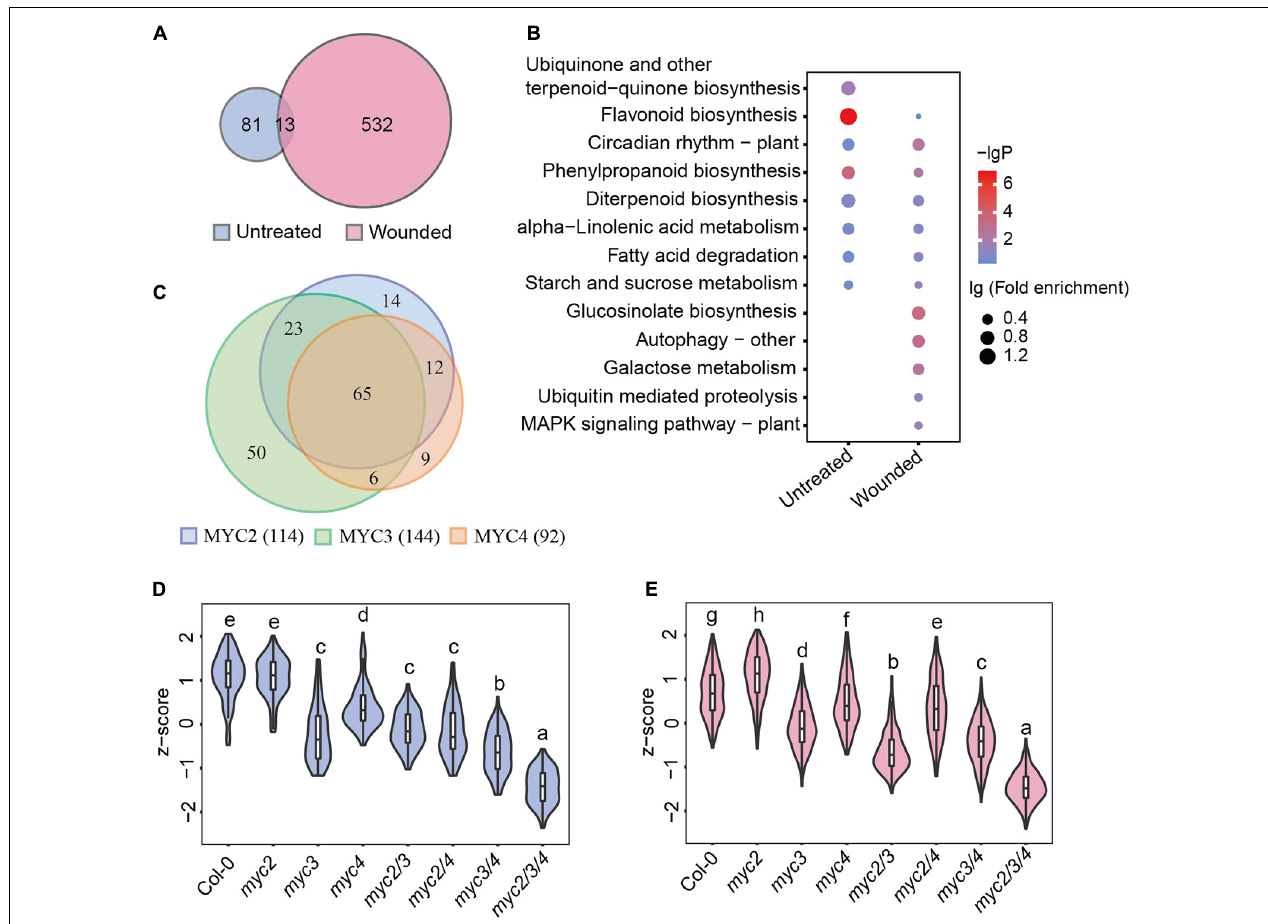
FIGURE 3 | MYC3 has the most significant impacts on the MGAI expressions. (A) Venn diagram of MGAIs in untreated (blue) and wounded (red) plants. (B) GO enrichment analysis of MGAIs as described in panel (A) . The dot represents lg (fold enrichment), and color stands for –lg( P -value). (C) Venn diagram of MYC2-, MYC3-, and MYC4-affected MGAIs. Blue, green, and orange, respectively, stand for the total MGAIs affected by MYC2, MYC3, and MYC4 in untreated and wounded plants as described in Supplementary Figure 5 . (D,E) Expressions of the MGAIs obtained from the untreated (D) and the wounded (E) plants, as described in panel (A) . The TPM of each gene was normalized into z -score. The detailed MGAI information is listed in Supplementary Table 11 . Data are analyzed by one-way ANOVA and Tukey’s HSD test. Different letters indicate significant differences, P -value <